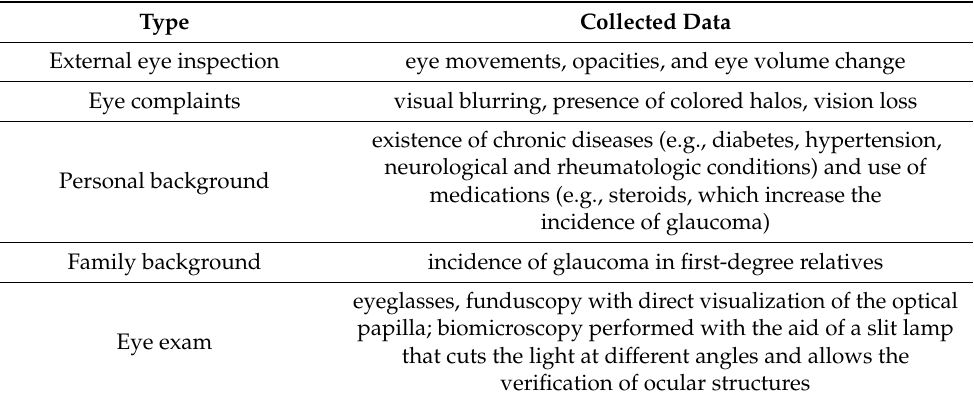
Table 1. Example of anamnesis